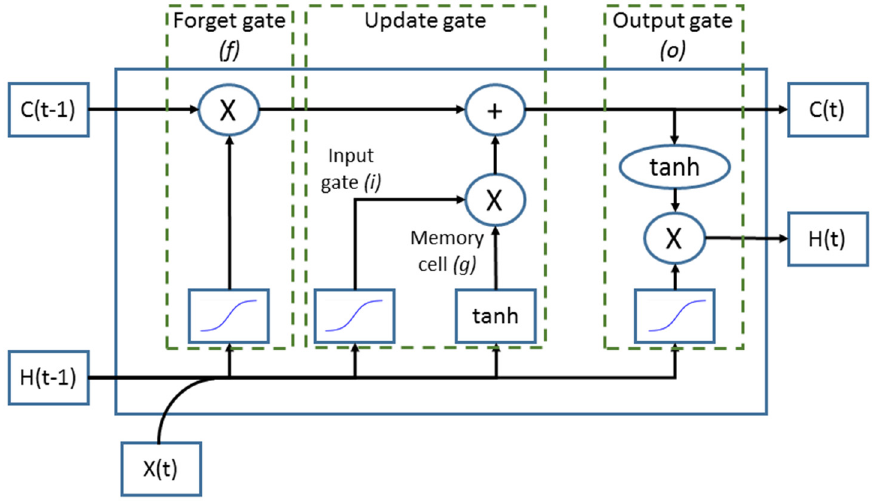
Figure 4. The typical structure of a long short-term memory (LSTM) cell including its fundamental elements, i.e., the forget gate, the input gate, the output gate and the cell state.